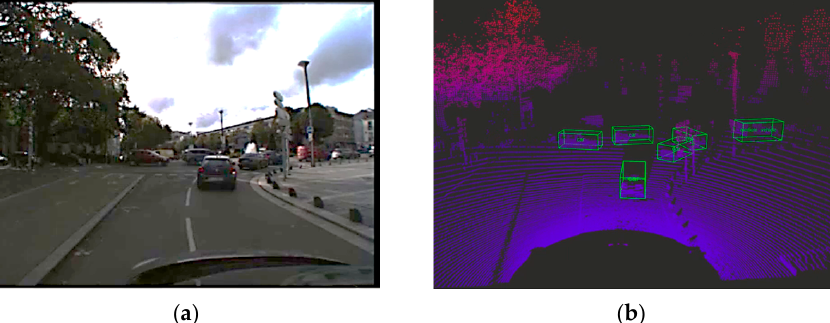
Figure 9. Object detection by DCNN: ( a ) camera image for illustration and ( b ) result of lidar DCNN detection.